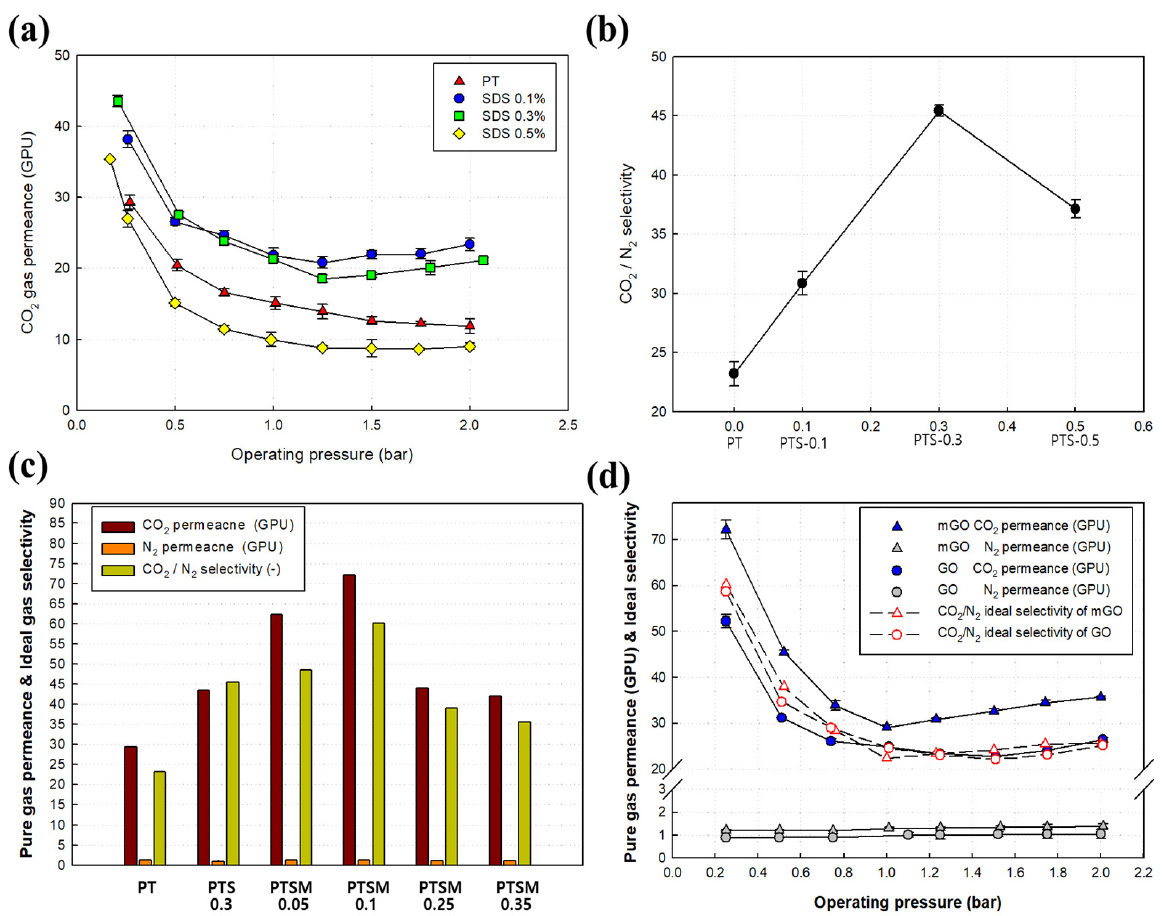
Figure 8. The impact of pressure, SDS, and GO concentration on CO 2 and N 2 permeance and selectivity. ( a ) Effects of the operating pressure and membrane type on CO 2 permeance. ( b ) Ideal selectivity of the PT and PTS TFC hollow fiber membranes, ( c ) Thin-film composite hollow fiber membrane permeance and ideal selectivity ( d ) Comparison of CO 2 and N 2 permeance and ideal selectivity between mGO (PTSP 0.1) and the GO thin-film composite hollow fiber membrane.